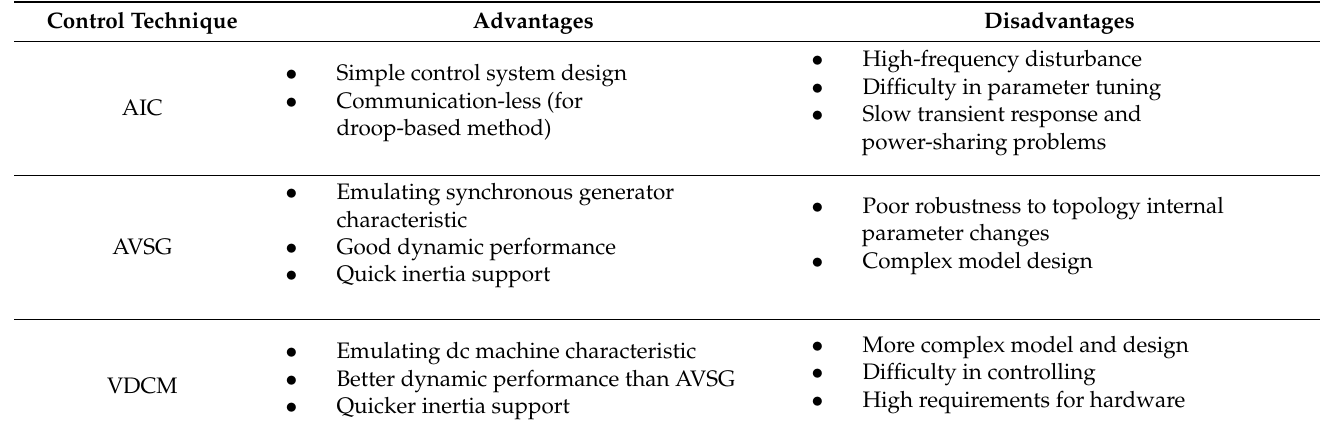
Table 3. Summary of virtual inertia control